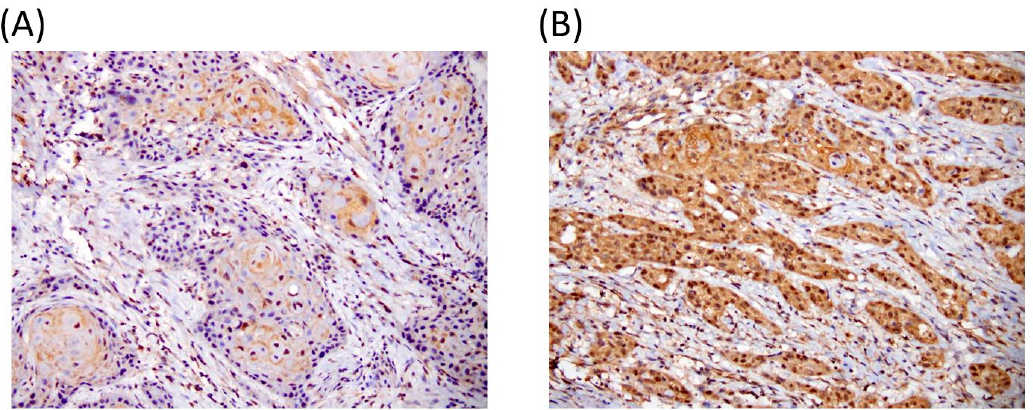
Figure 1. Representative immunostaining of ( A ) low and ( B ) high EIF5A2 expression of oral squamous cell carcinoma (OSCC) specimens.